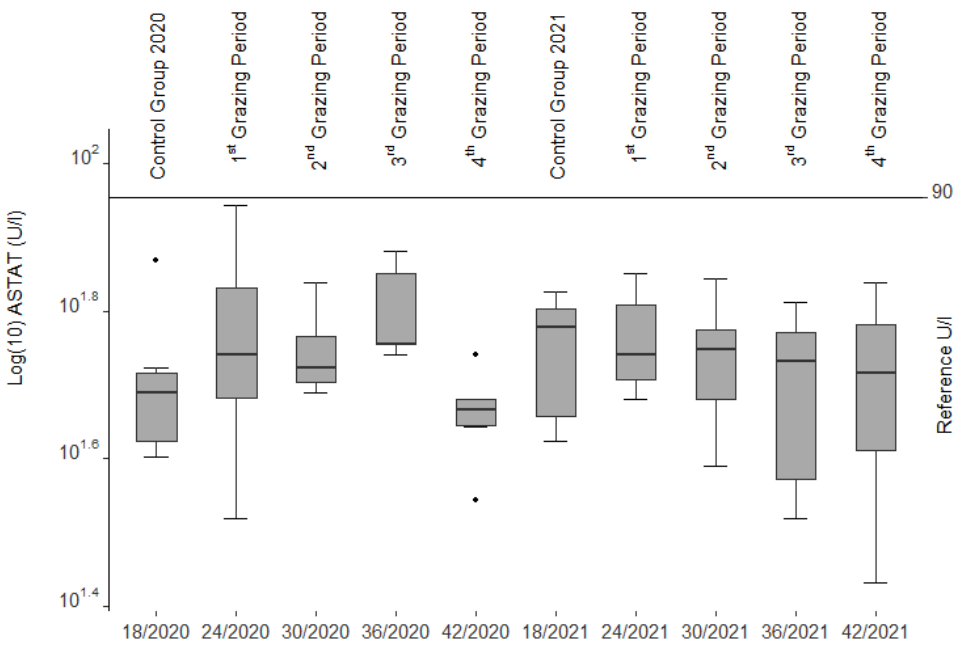
Figure 2. Aspartate aminotransferase (ASAT) activities from blood serum of the slaughtered sheep. Please note the three single statistical outliers.